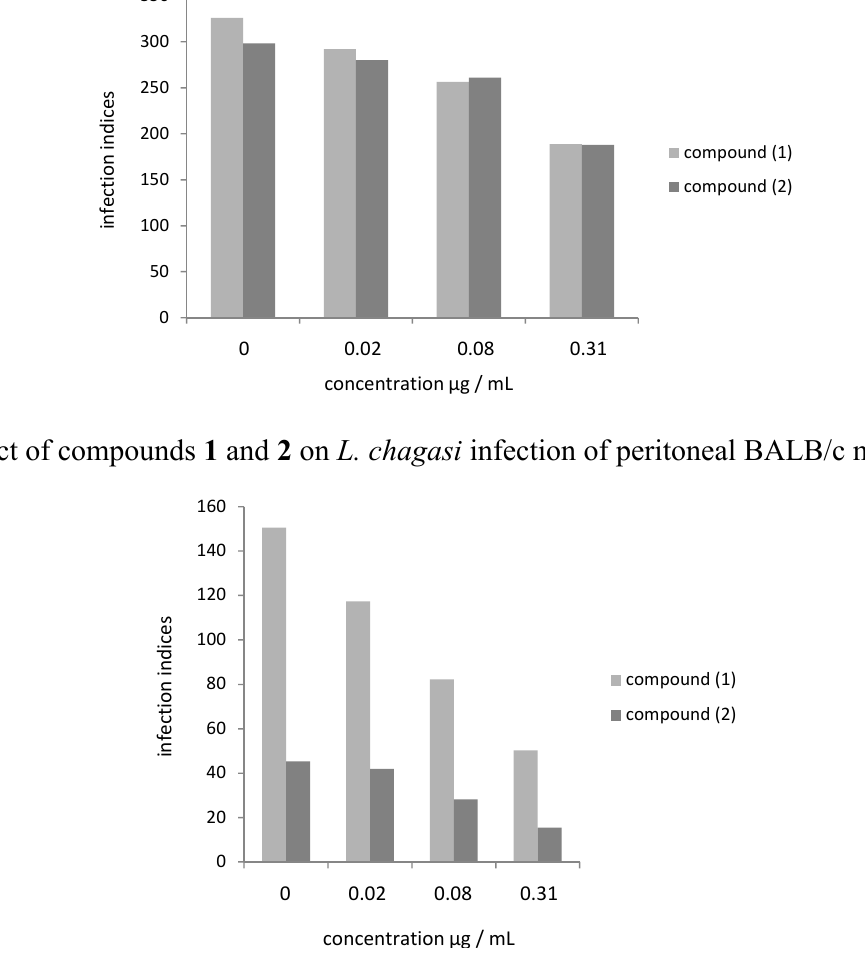
Figure 2. Effect of compounds 1 and 2 on L. amazonensis infection of peritoneal BALB/c macrophages.